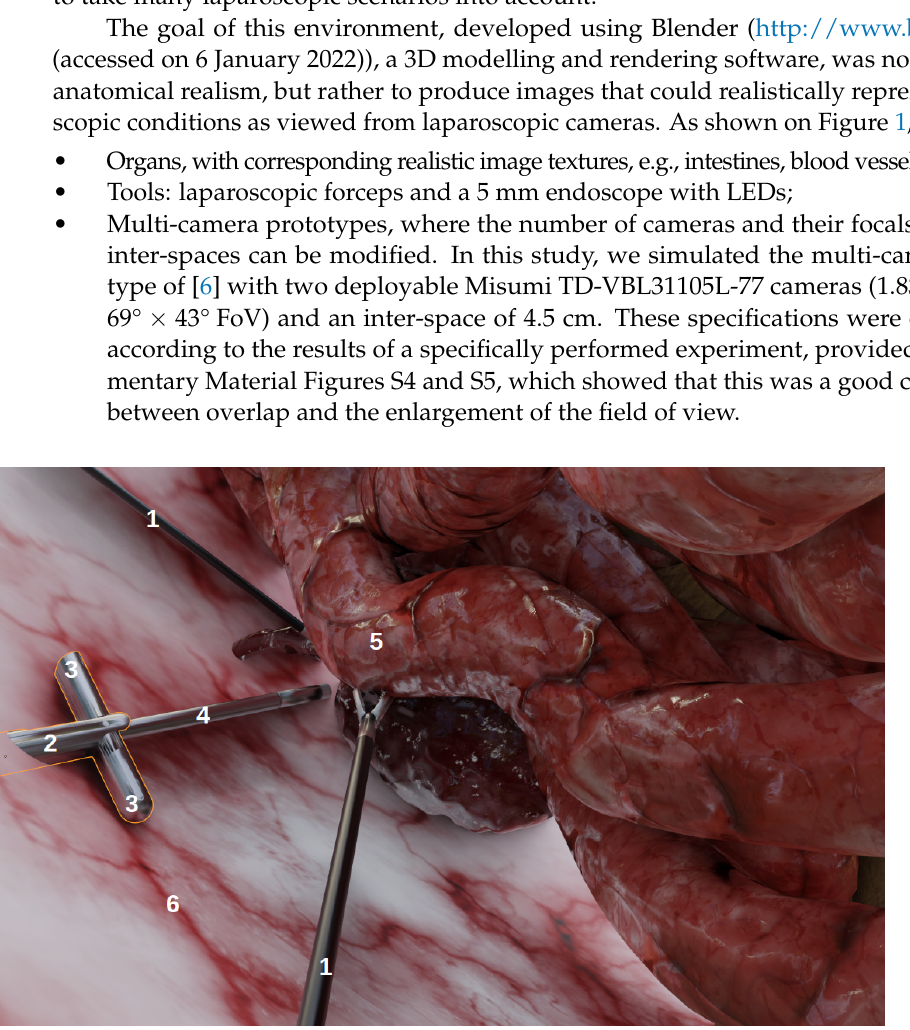
Figure 1. The simulated environment viewed from a user perspective in Blender. This is not a camera perspective and thus, does not include the rendering (e.g., illumination, shadows). (1) The laparoscopic forceps, (2) the multi-camera prototype, (3) two deployed cameras, (4) the endoscope, (5) organs, (6) the